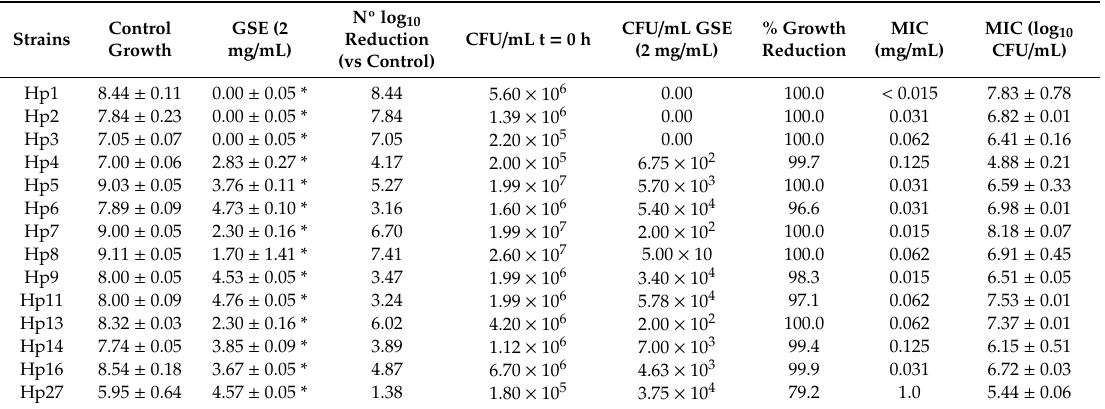
Table 3. E ff ects of procyanidin-rich extract on the viable counts of di ff erent H. pylori